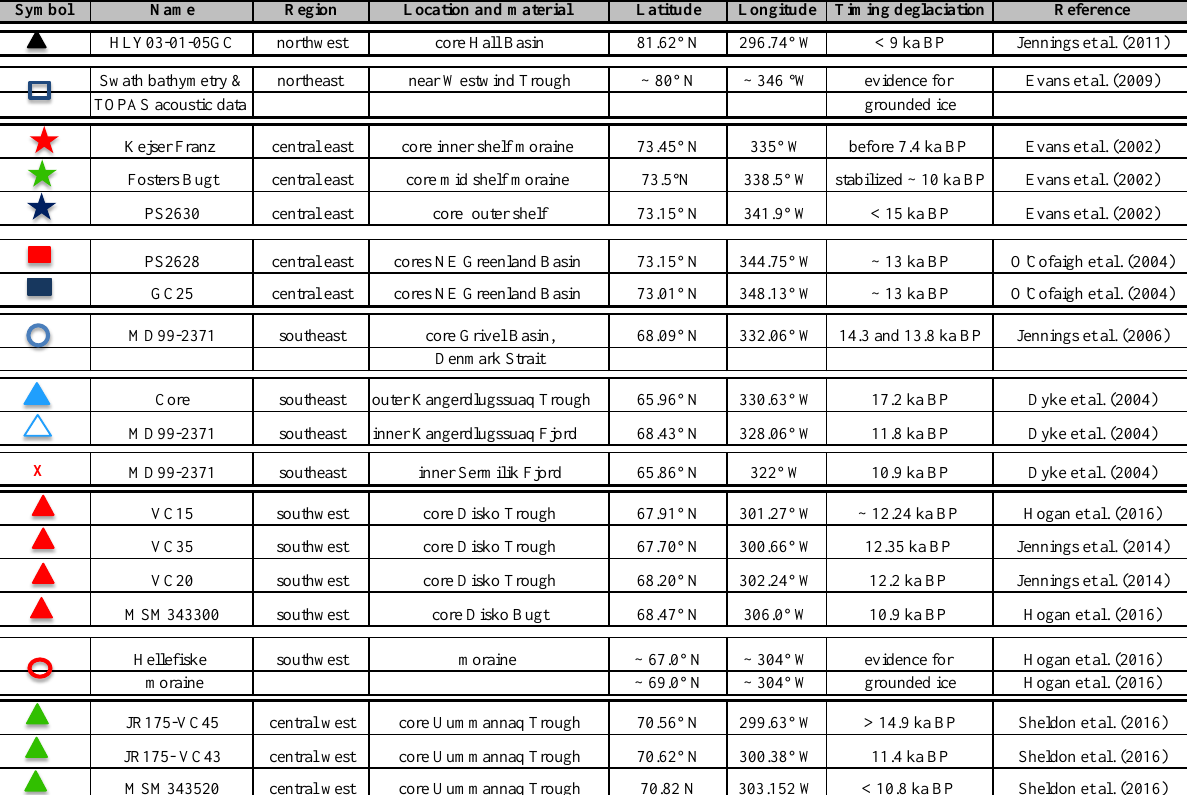
Table 1. Summary of a selection of the observational data which were used to constraint the timing and spatial extent of the grounded ice sheet (Fig.